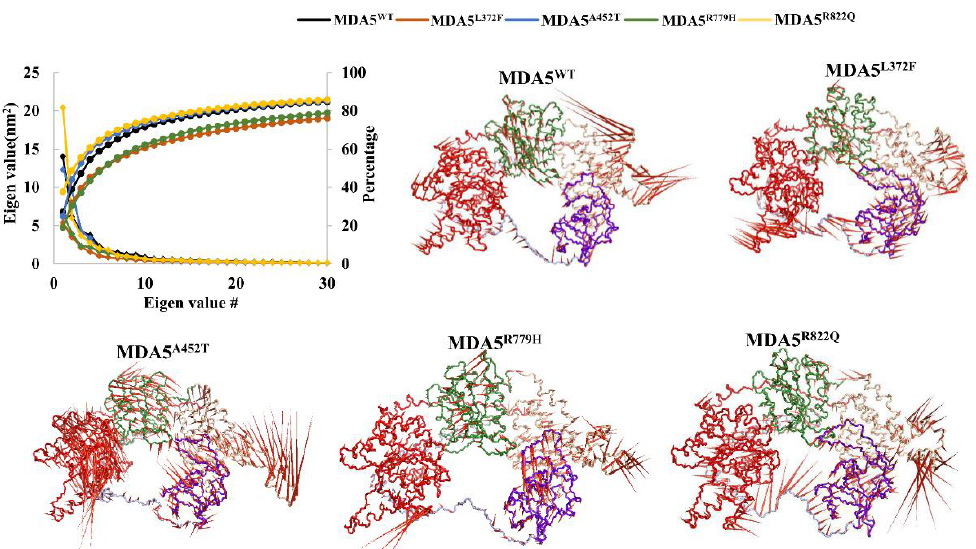
Figure 4. Cumulative percentages and porcupine plots from the principal component analysis. The cumulative percentages of the first 30 principal components are shown (top left corner). Porcupine plots were made using PyMOL for PC1 with 50 frames of the whole trajectory using the filter option. The domains are color coded as per the colors represented in Figure 1B.